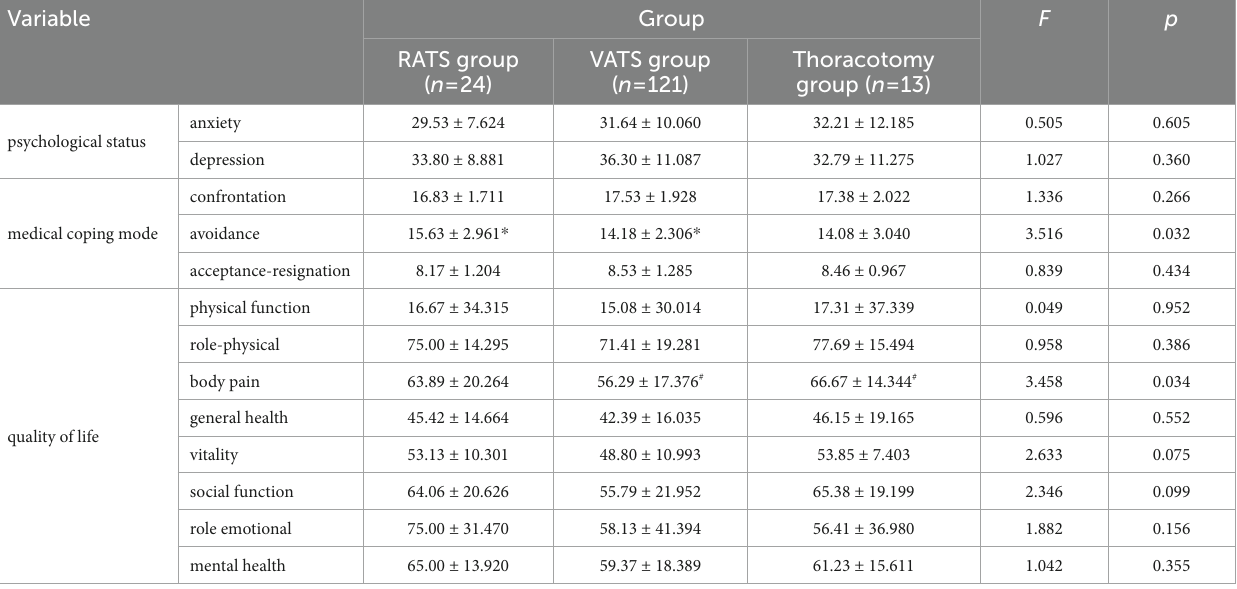
TABLE 3 Comparison of the effects of different surgical approaches on the psychological status, medical coping modes and quality of life of patients with lung cancer.